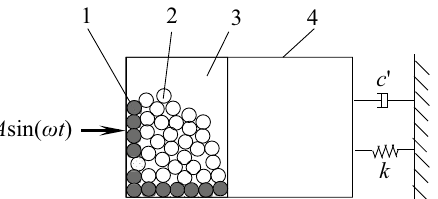
Figure 2. Momentum exchange and consumption of energy. 1—particles of momentum exchange; 2—other particles; 3—particle damper; 4—vibration system.